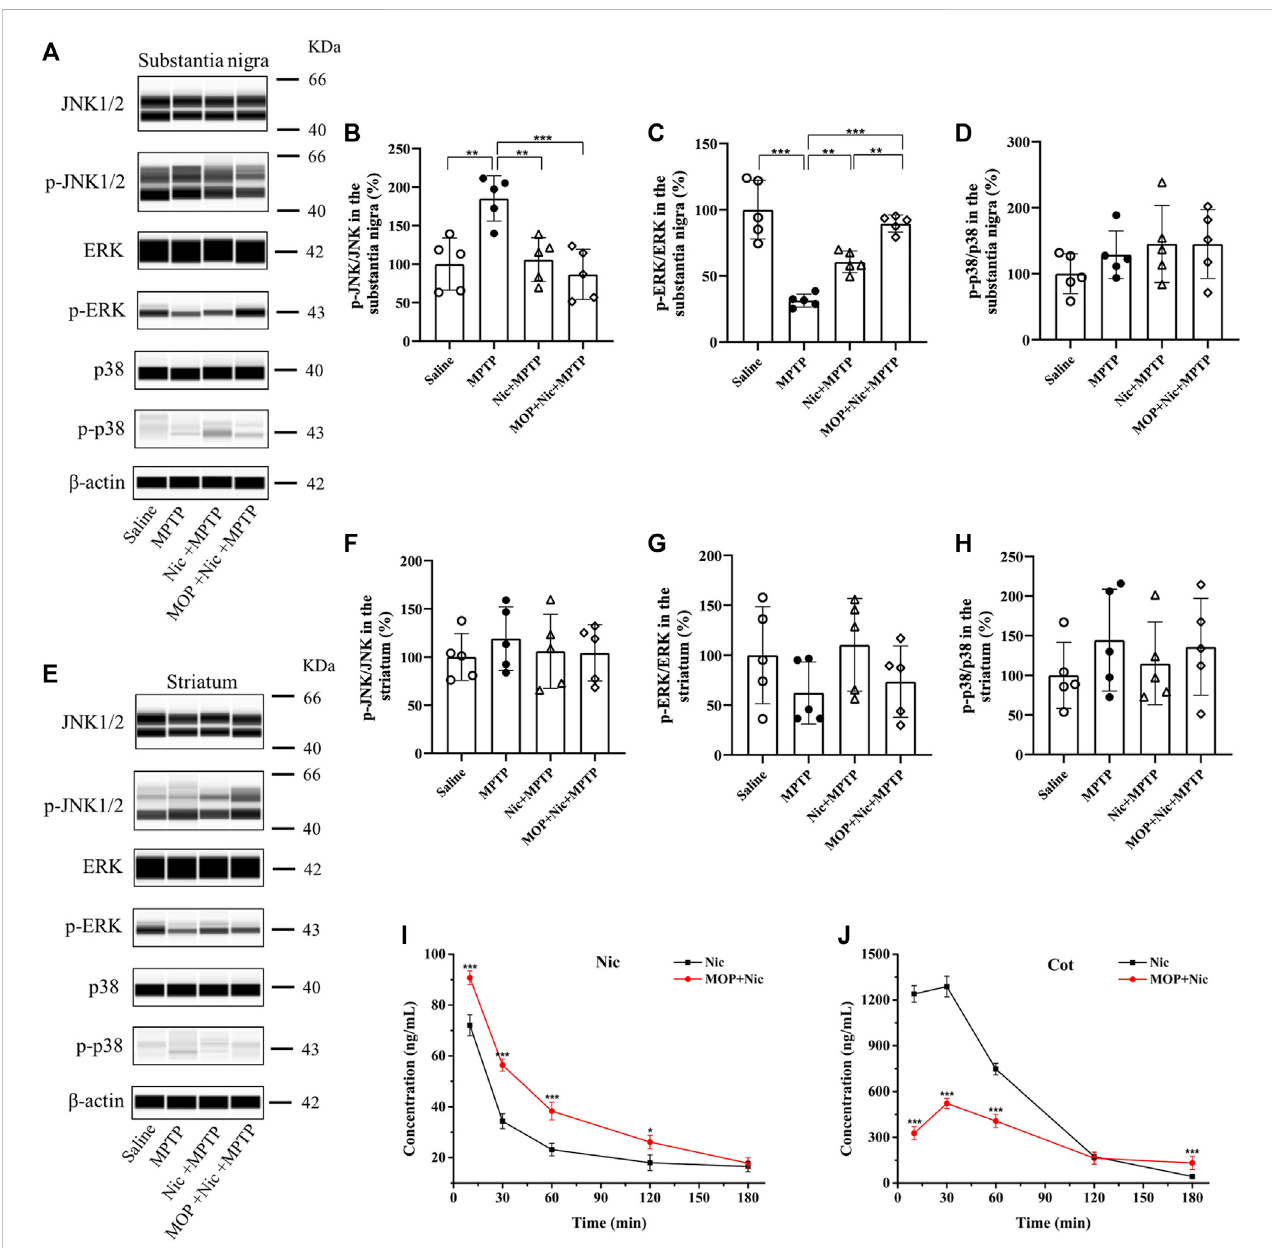
FIGURE 6 Effects of nicotine on the MPTP-induced expression of MAPK signaling pathways. Representative pictures and quanti fi cation for immunoblot analysis of p-JNK/JNK,p-ERK/ERK,p-p38/p38fromthesubstantianigra (A) andstriataltissues (E) areshown. (B,C,D) Statisticalresultsofp-JNK/JNK,p-ERK/ERK,p-p38/ p38inthesubstantianigra. (F,G,H) Statisticalresultsofp-JNK/JNK,p-ERK/ERK,p-p38/p38statisticsinthestriatum. (I,J) Concentration-timecurveofnicotine and cotinine in plasma of saline and MOP-pretreatment mice. Data are expressed as mean ± SEM from four or fi ve mice in each group. Signi fi cant differences were determined by an unpaired Student ’ s t-test and one-way ANOVA followed by Tukey ’ s multiple comparison post hoc test. * p < 0.05, ** p < 0.01, *** p <